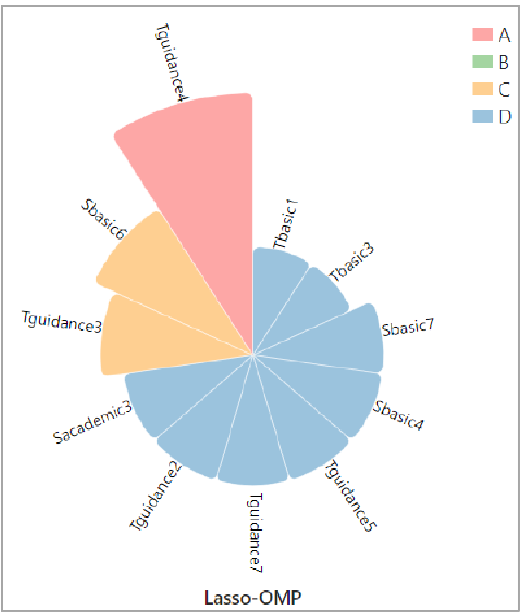
Figure 4. Ranking results from the synthesis of two factor selection methods (Lasso and